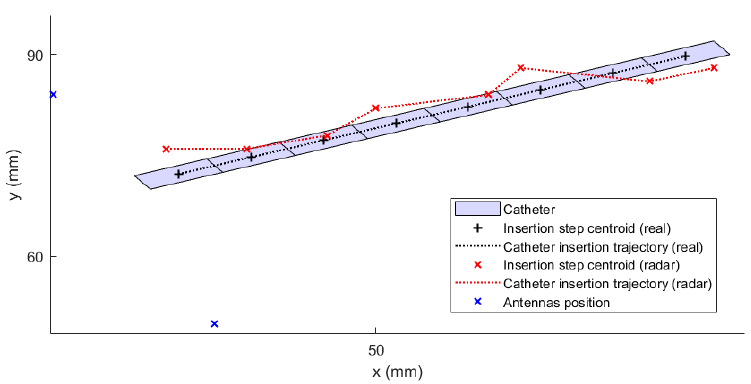
Figure 19. Estimated catheter tip position detection during insertion (red dotted line). Table 5. Detection accuracy of the catheter position detection during insertion.